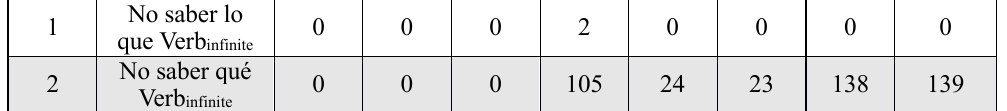
Table 7: occ. embedded lo que -SFRs and qué -interrogatives with infinite verbs 1